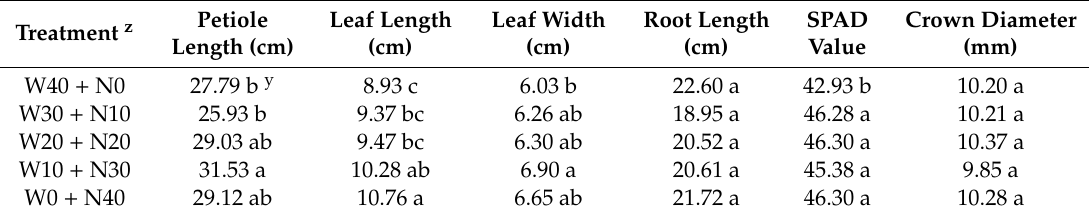
Table 3. Growth characteristics of “Maehyang” strawberry runner plants a ff ected by the nutrient solution resupply period during the nursery stage ( n = 12).